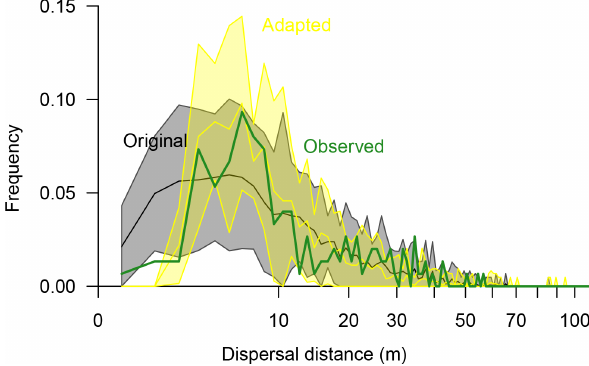
Figure 5. Seed dispersal of Larix gmelinii as simulated with the original simulation model LAVESI (black line surrounded by a grey band showing the 95% confidence interval) and the adapted model version (yellow line and band showing the 95% confidence interval) compared to observed effective seed dispersal (green thick